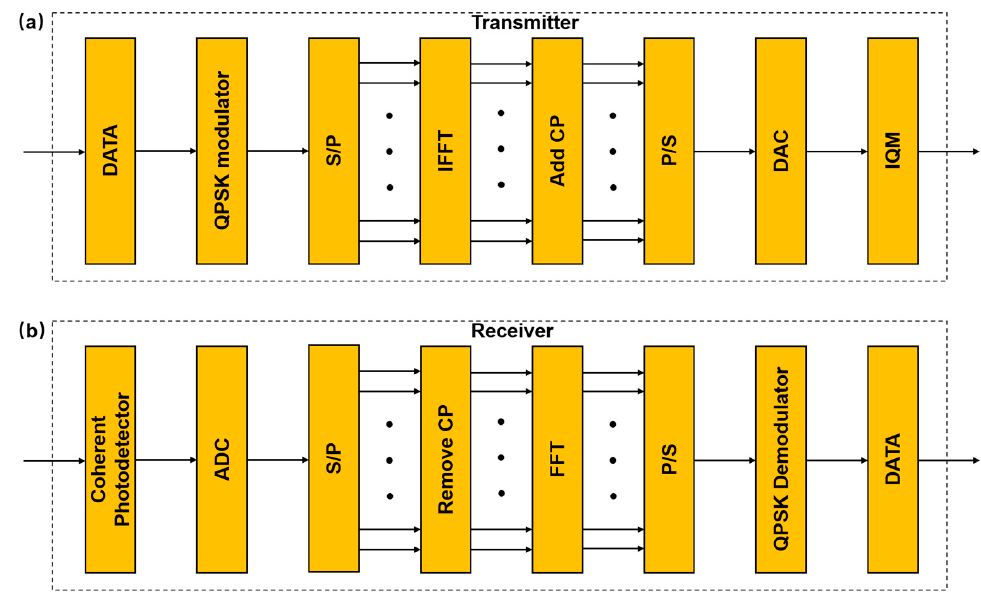
Figure 2. Processes of ( a ) the generation of the CO-OFDM-QPSK signal at the transmitter and ( b ) the demodulation of the signal at the receiver.